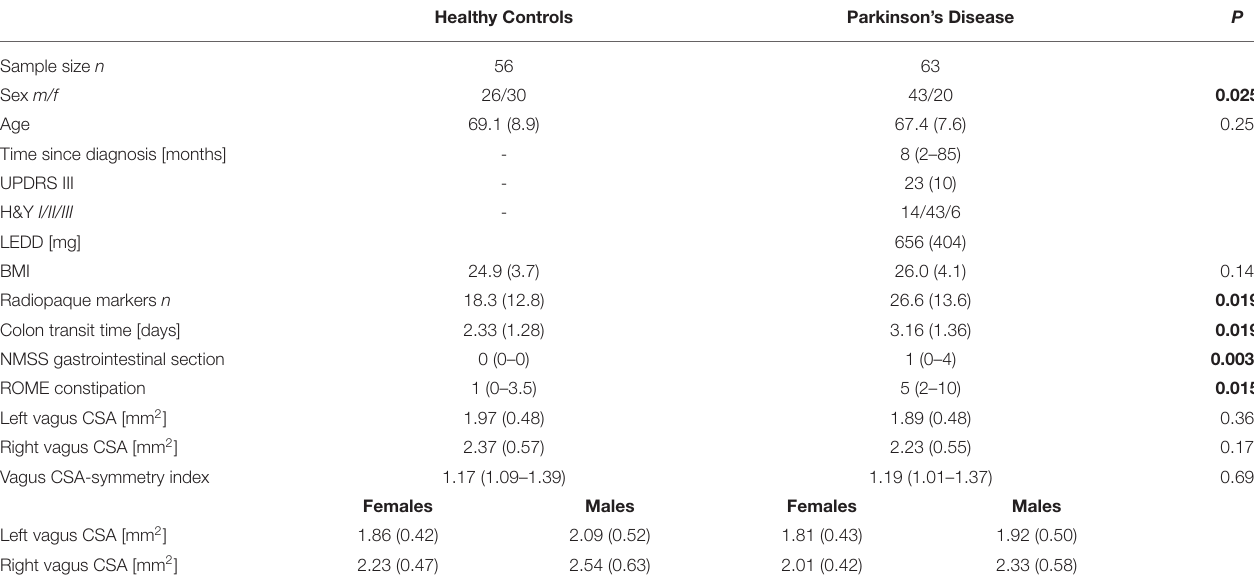
TABLE 1 | Demographic and clinical information.